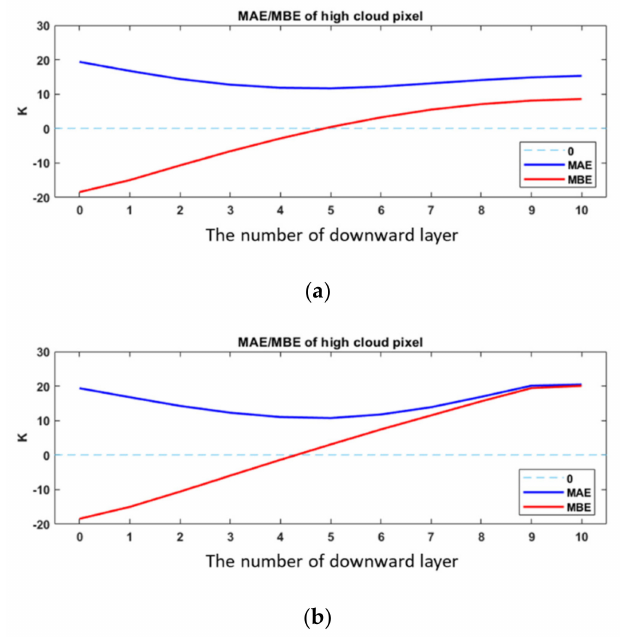
Figure 12. MAE and MBE for 10.4 µ m BT of high cloud. Valid on June 2, 2017 at 1200 UTC. ( a ) Qi only and ( b )